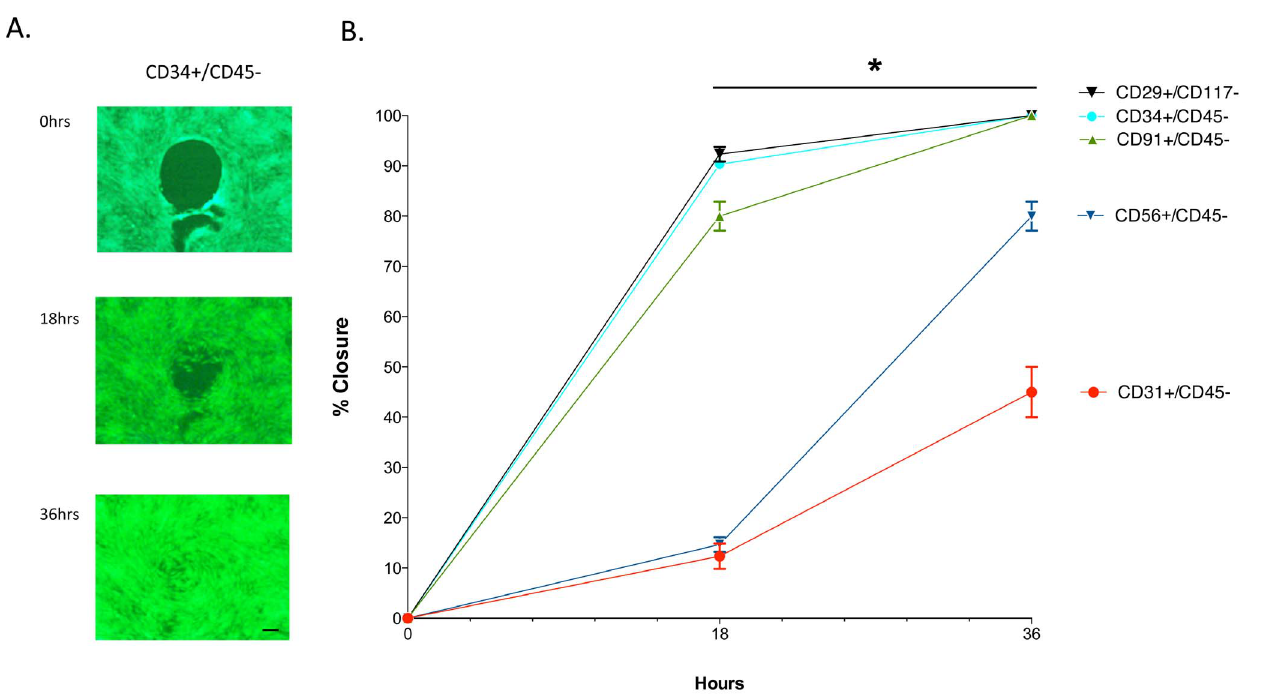
Fig. 6. Migration characteristics of CD29, CD31, CD34, CD56 and CD91 positive cells. Fluorescent-conjugated antibodies to CD29, CD31, CD34, CD56 and CD91 were used to separately sort and subculture cells from collagenase 2 digested human muscle tissue. The cells were seeded into wells of a Gap- Closure Assay plate. When the wells were confluent the circular plug was removed to allow the cells to migrate into the space. The graph indicates the % closure of the circular space at the indicated times (mean ¡ SEM, n 5 8). A significant difference is noted (*) in migration rates between CD56 and CD31 compared to CD29, CD34 and CD91, between time points of 18 to 36 hours (Mann-Whitney U Test, p # 0.01). Scale bar 5 100 m